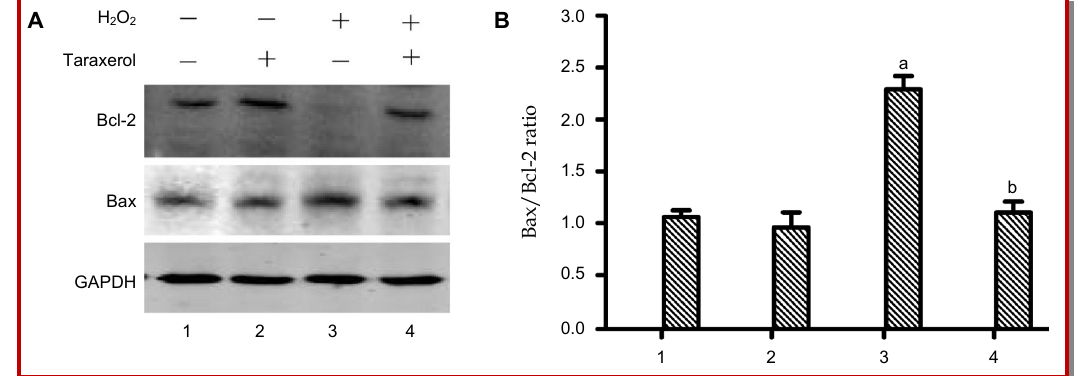
Figure 5: Effects of taraxerol on H 2 O 2 -induced Bcl-2 and Bax. L02 cells were treated with taraxerol or H 2 O 2 for 12 hours, A) Bcl-2 and Bax were tested by Western blotting. GAPDH was used to confirm that equal cell equivalents were loaded. B) The graph shows the ratio of Bax/Bcl-2 in Figure 5A . Data represent the mean ± SD (n = 3); a p<0.01 compared with control; b p<0.01 com- pared with the group of H 2 O 2 -treated L02 cells alone